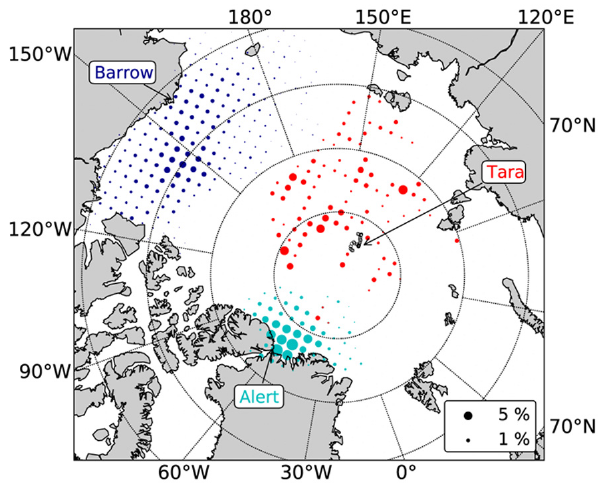
Fig. 1. Distribution of the trajectory starting points upwind of Alert (light blue), Barrow (dark blue) and Tara (red) for JRA and ERA combined. The grid cell size is 100km and the size of the circles indicates the relative frequency. The arrows mark the in situ stations and the Tara drift track in April 2007.